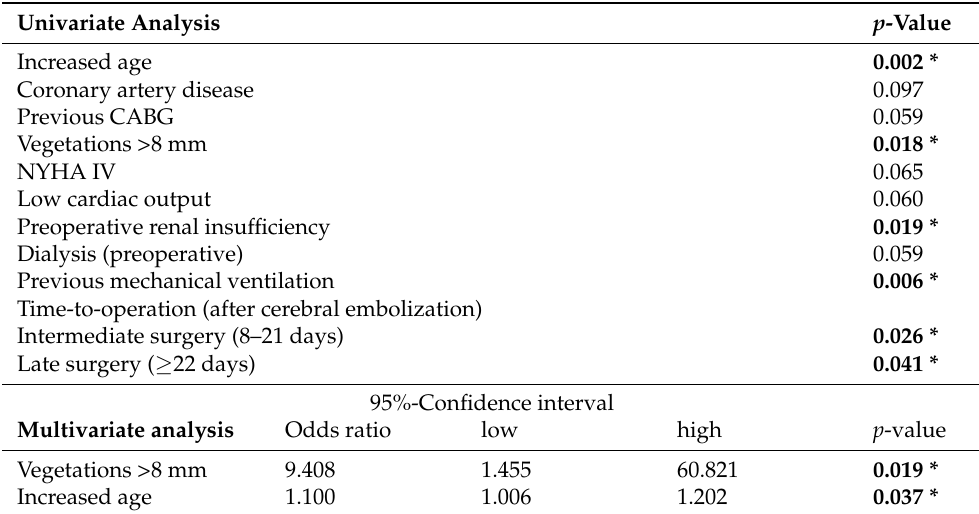
Table 5. Uni- and multivariate analysis to identify risk factors for in-hospital